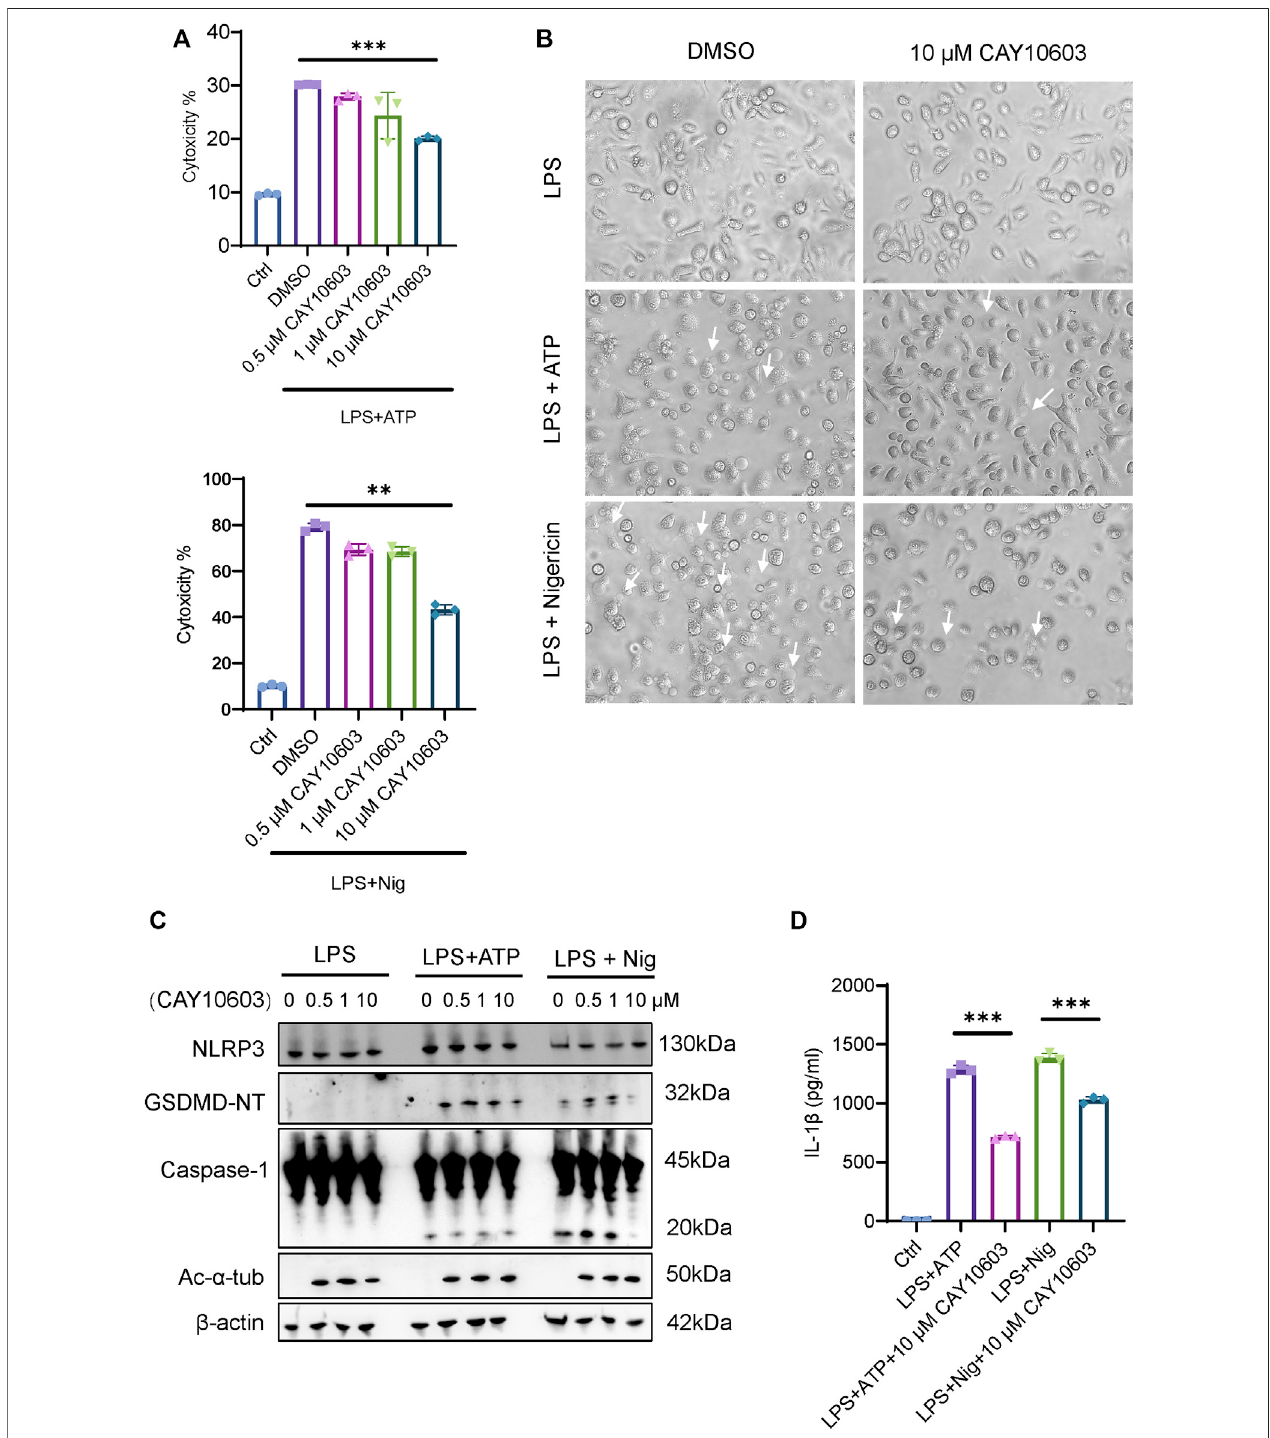
FIGURE 7 | HDAC6 inhibition suppresses NLRP3 activation in macrophages. (A) Supernatants from the indicated iBMDMs were analysed for cell death, as measuredbylactatedehydrogenase(LDH)release. (B) ImagesweretakenafterLPS+ATP/NigchallengewithorwithoutCAY10603pretreatment.Arrowsindicatecells exhibiting pyroptotic-like features. (C) Representative western blot analysis of HDAC6, NLRP3, GSDMD-NT, Caspase-1, and Ac- α -Tub levels in iBMDMs after LPS + ATP/Nig challenge with or without CAY10603treatment. (D) Supernatants from the indicated iBMDMs were analysed for IL-1 β . ** p < 0.01; *** p < 0.001. Two-way